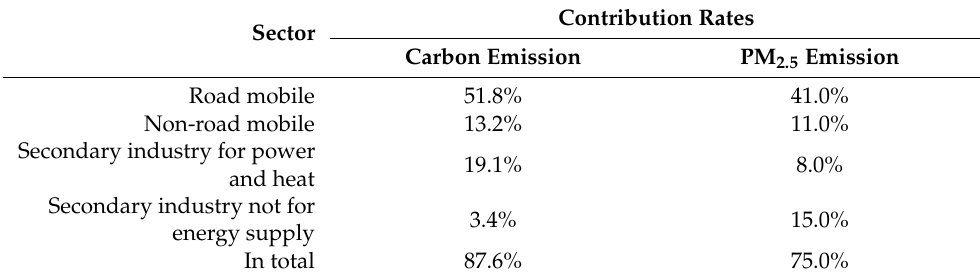
Table 10. Proportion of main sources of carbon emissions and PM 2.5 emissions in Shenzhen.